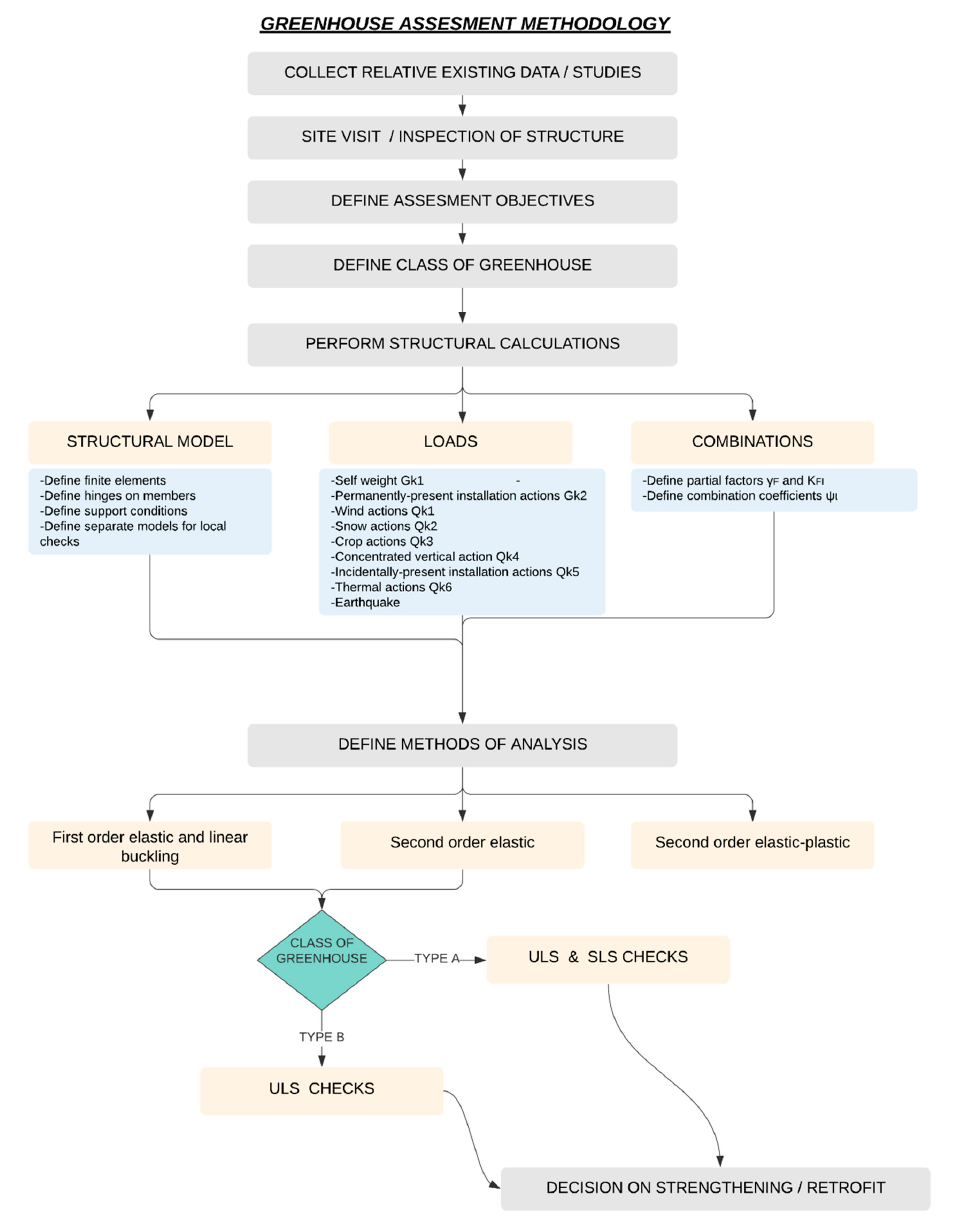
Figure 3. Flowchart of greenhouse assessment methodology. Abbreviations: Ultimate Limit State—ULS, Serviceability Limit